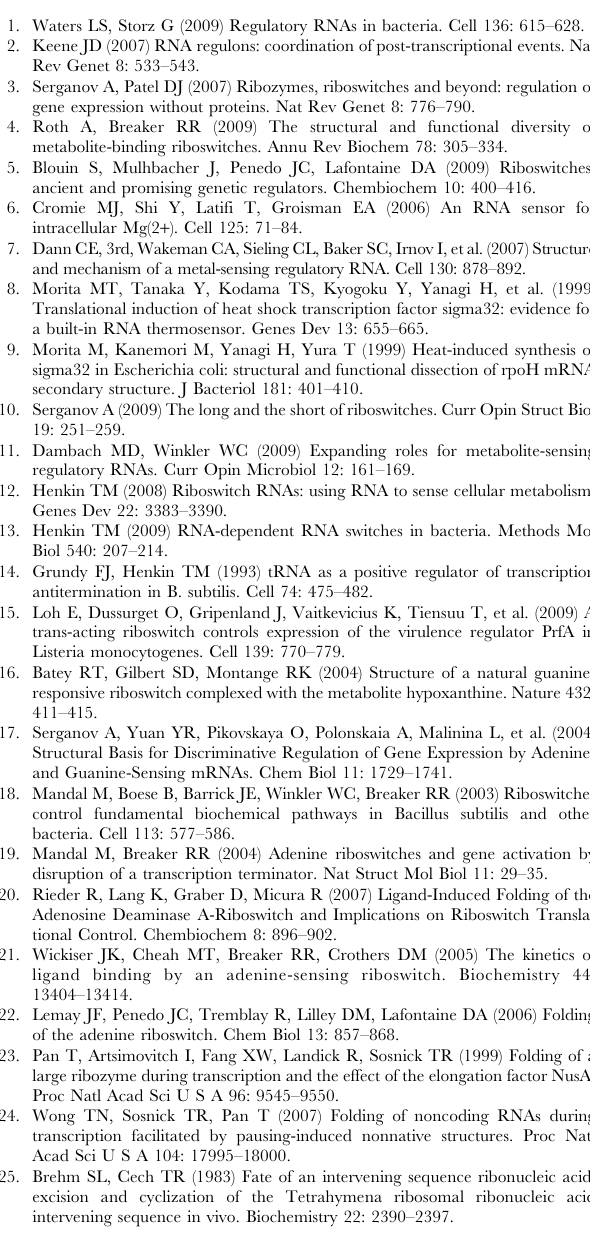
Figure S5 Transcription time course performed using B. subtilis RNAP showing transcriptional intermediates. Lanes A, C, G and U identify transcription assays conducted with 3 9 -O-Methyl-NTPs in the elongation mix. Transcriptions were performed for the indicated times to reveal transcriptional intermediates. The chase reaction (ch) was performed using 150 m M rNTP. The pause site identified in the region U114–U117 (P), the terminated (T) and the readthrough (RT) mRNA are indicated on the right of the